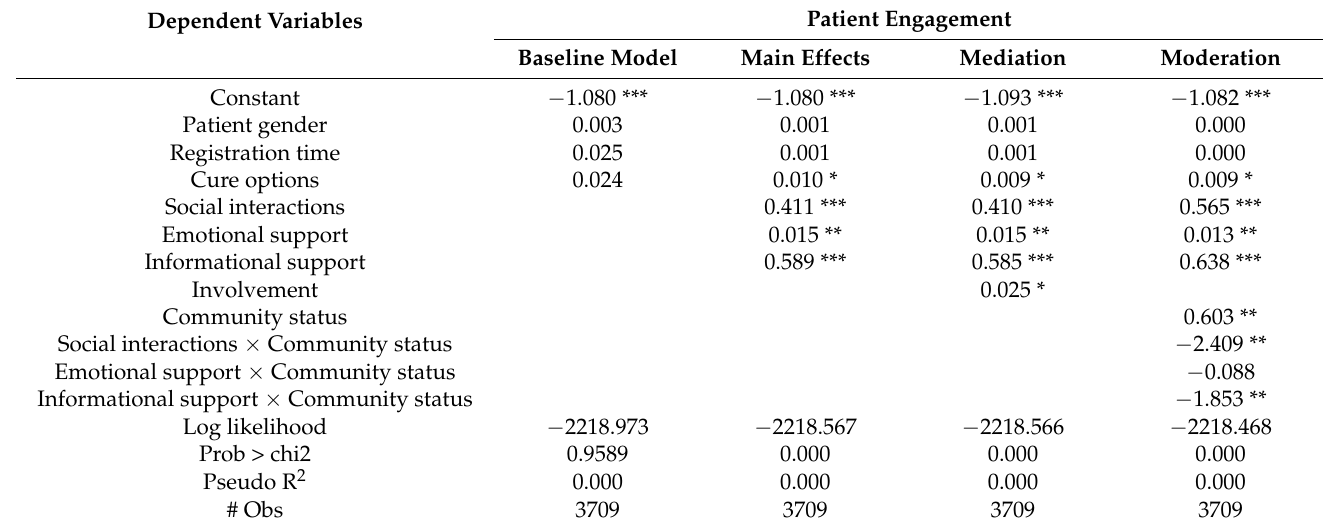
Table 6. Results of negative binomial